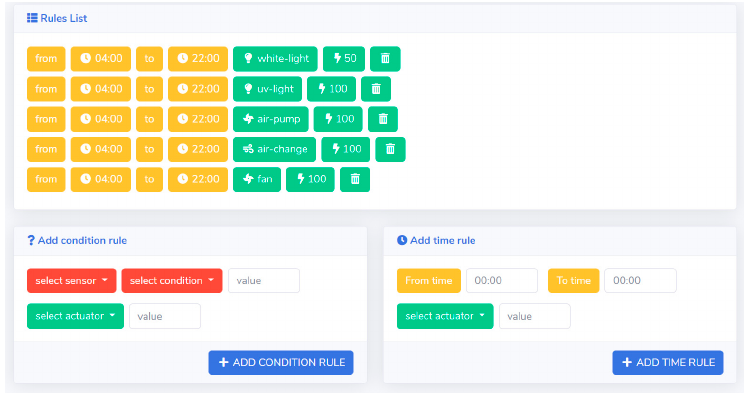
Figure 9. The rules editor on the webserver to make rules, which together form a recipe, which can be used to control the GrowBot.